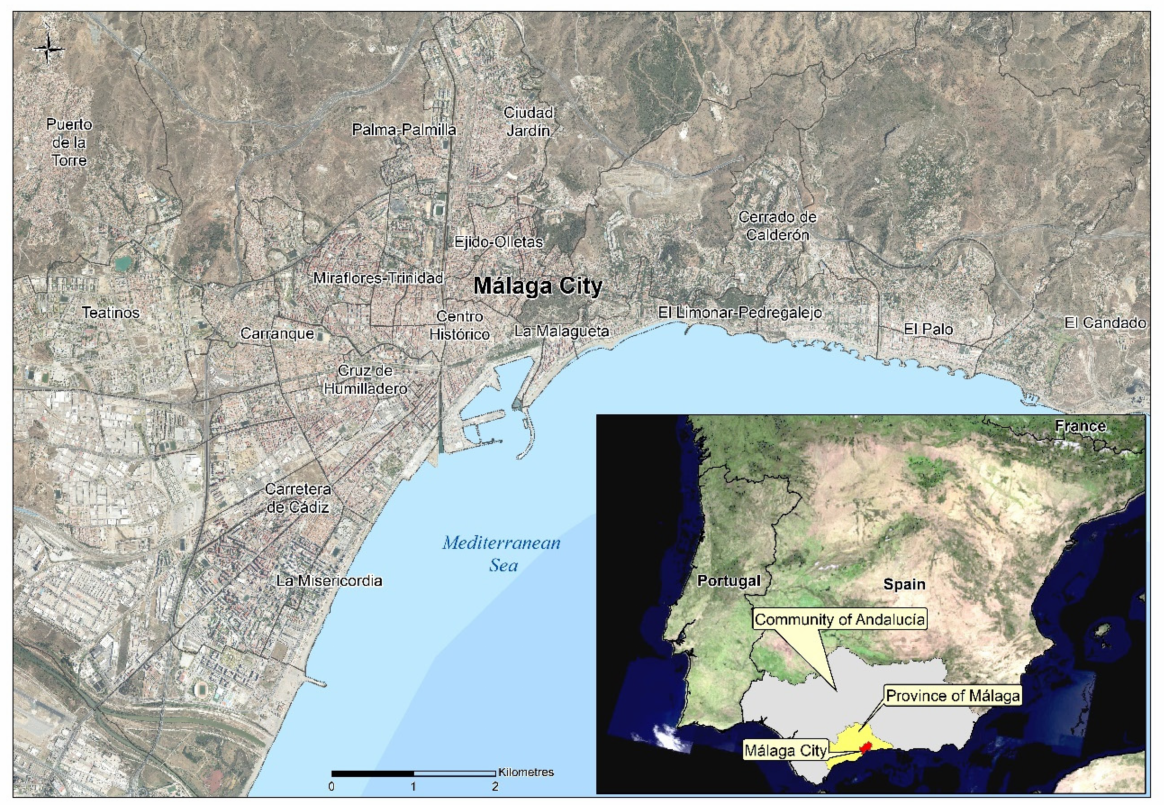
Figure 5. Study area. Own